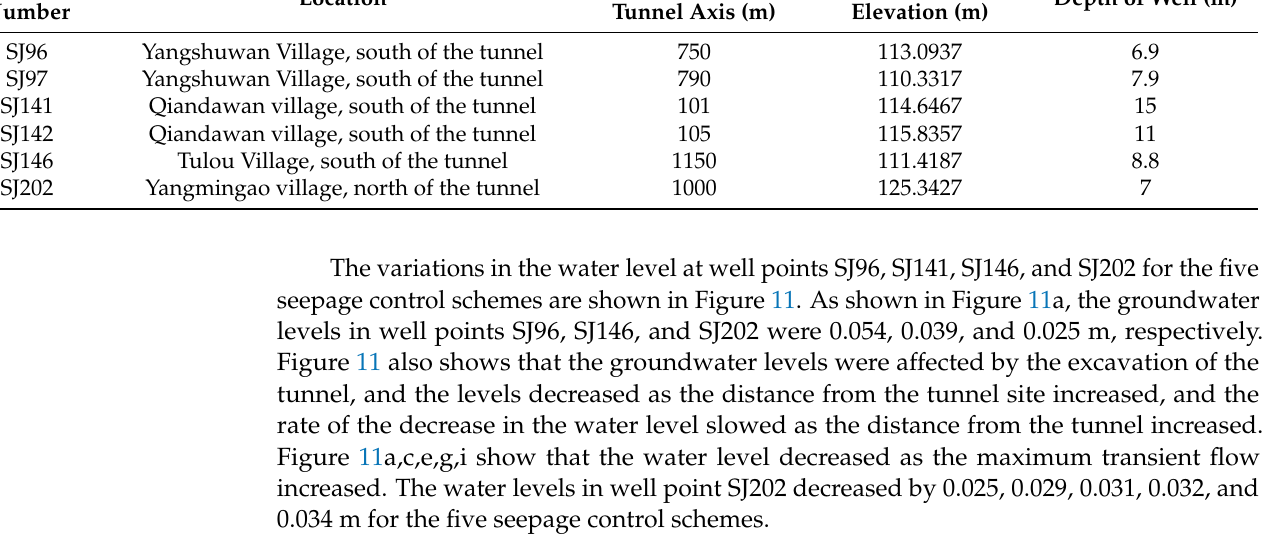
Table 3. Drained civilian Wells.